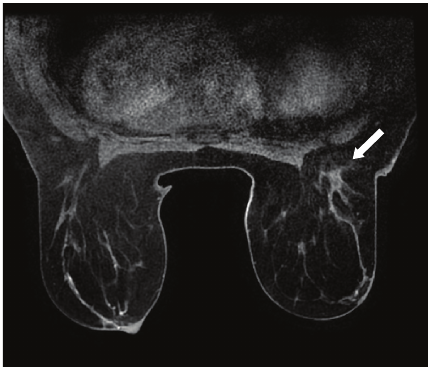
Figure 9: Contrast enhanced dynamic MRI of breast. The patient had surgical excision for granulomatous mastitis. Postcontrast enhancement is still seen in operative bed long time after surgery due to fibrosis in this region. It showed progressive enhancement on dynamic curve (not shown